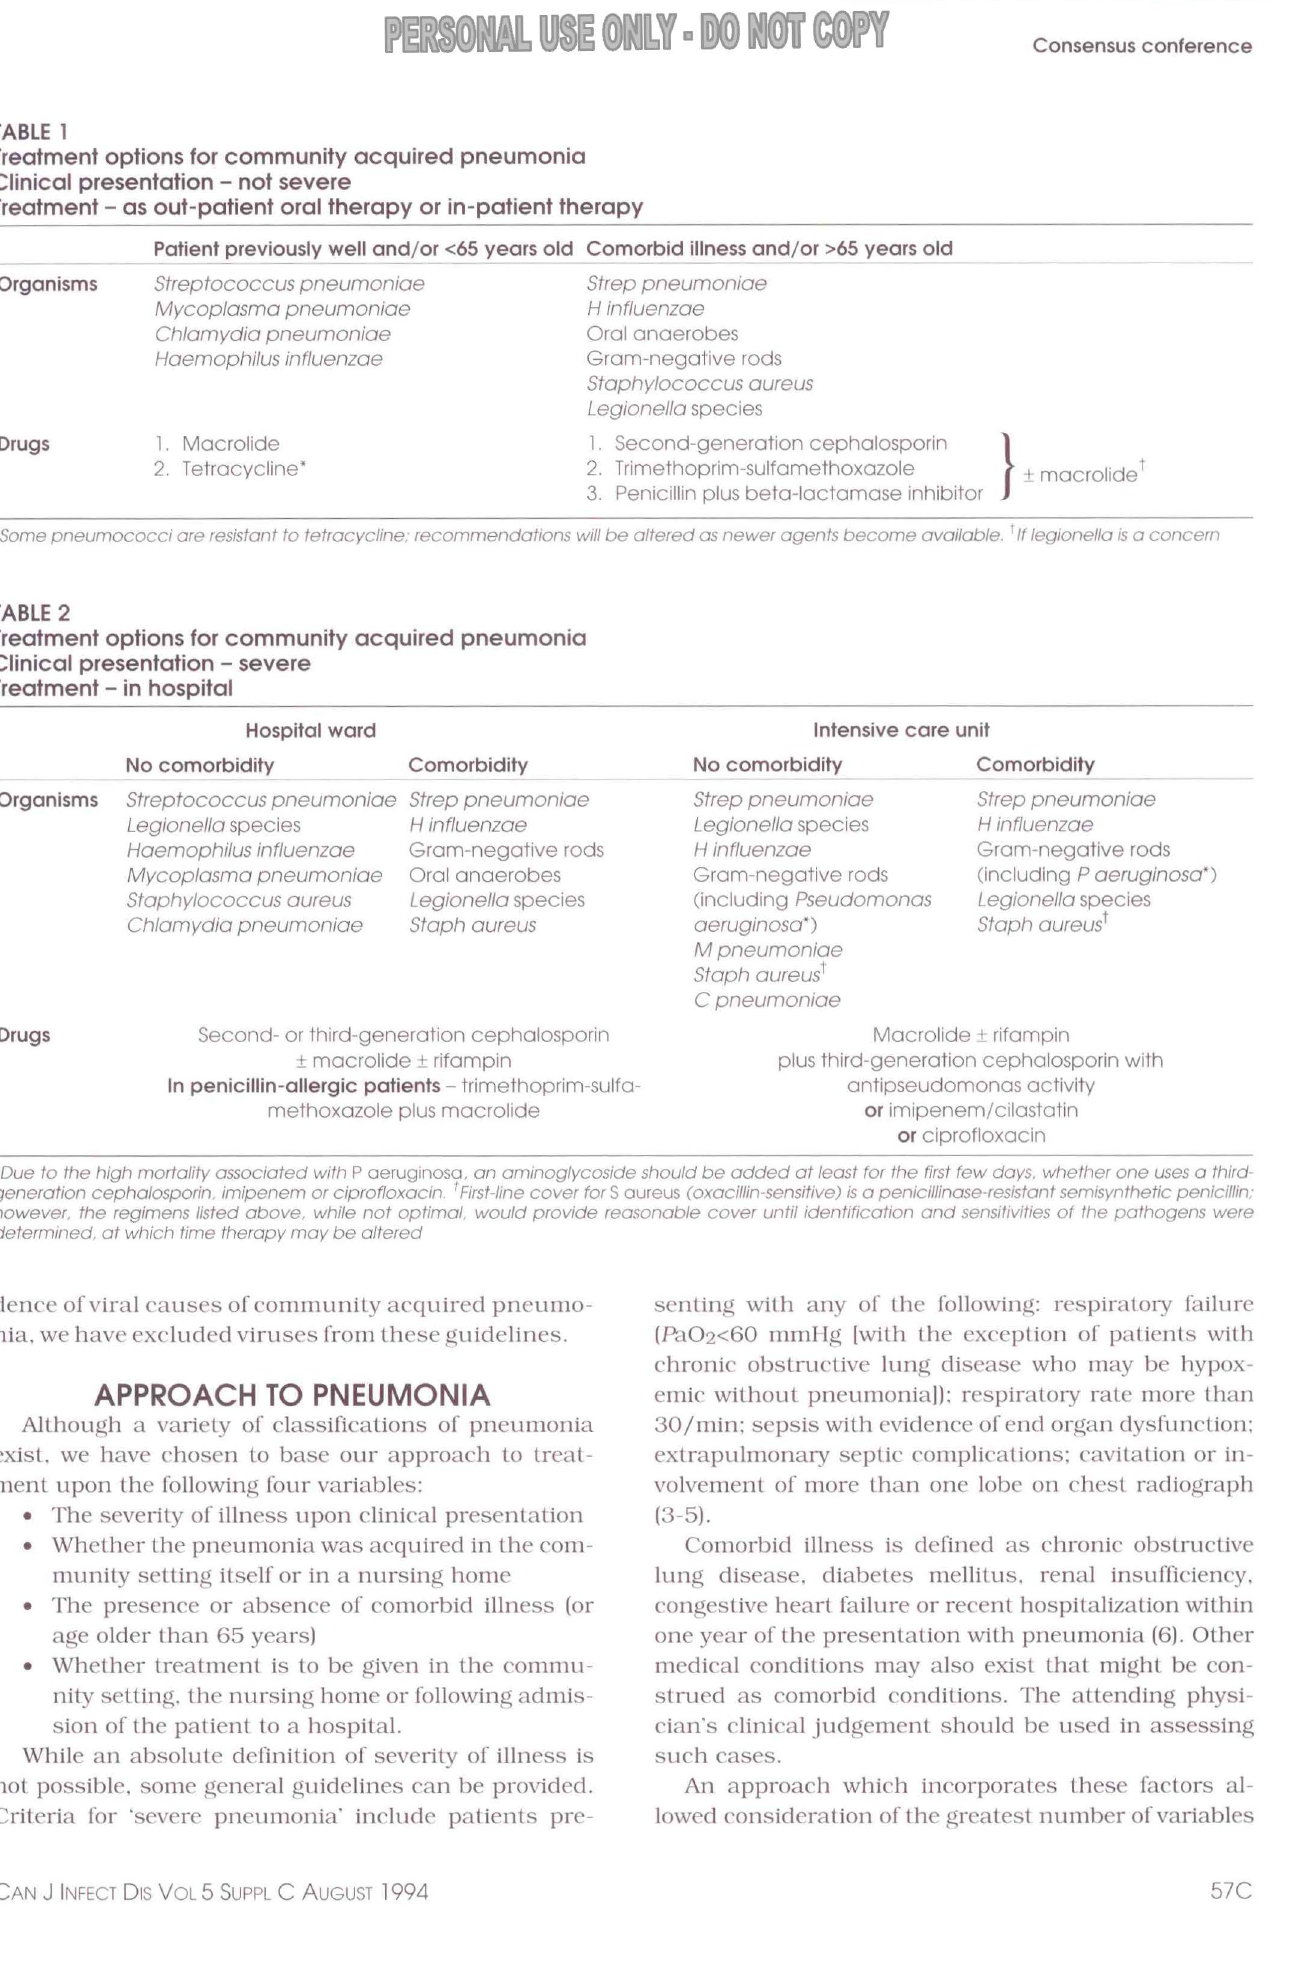
Y·DO Consensus conference